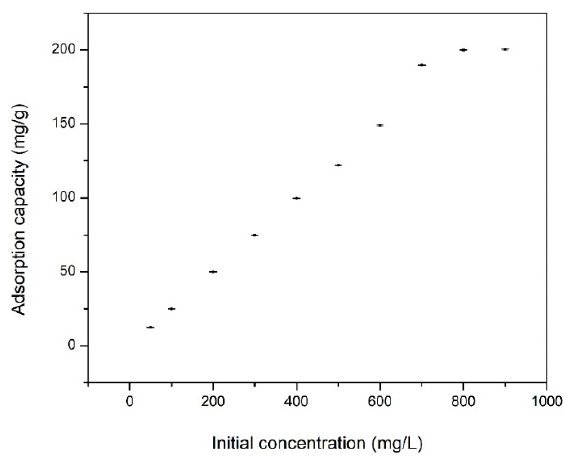
Figure 6. Effect of cadmium (II) initial concentration on Cd adsorption on functionalized chitosan. Figure 6. E ff ect of cadmium (II) initial concentration on Cd adsorption on functionalized